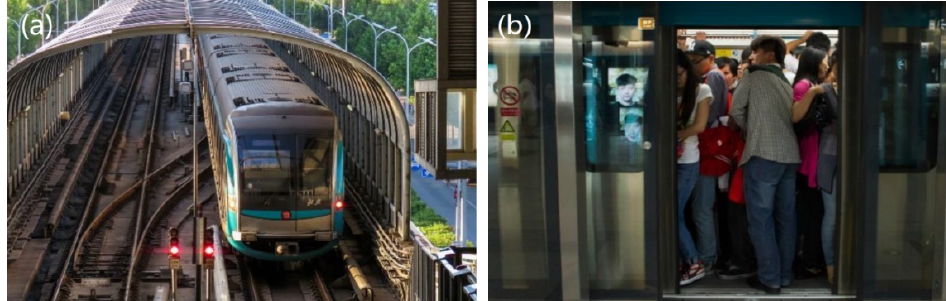
Figure 7. ( a ) Beijing metro line and ( b ) its passenger flow.